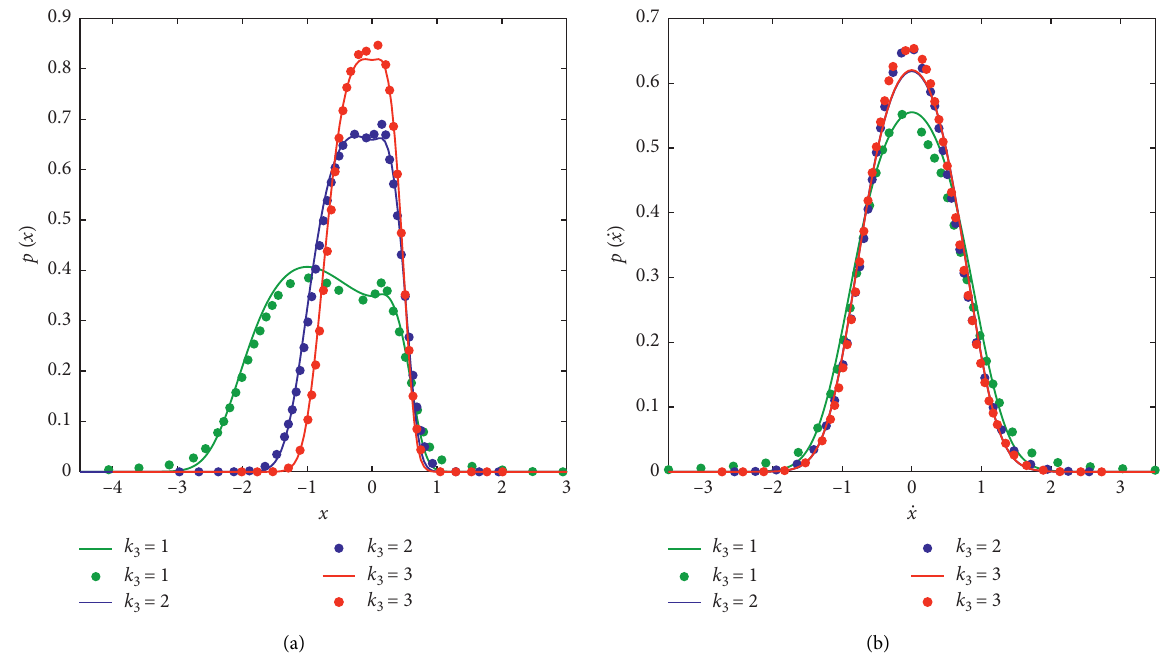
Figure 8: The PDF of the nonlinear system under different nonlinear stiffness coefficients k � − 1, solid lines: the analytical results, and circles: MCS ( k 1